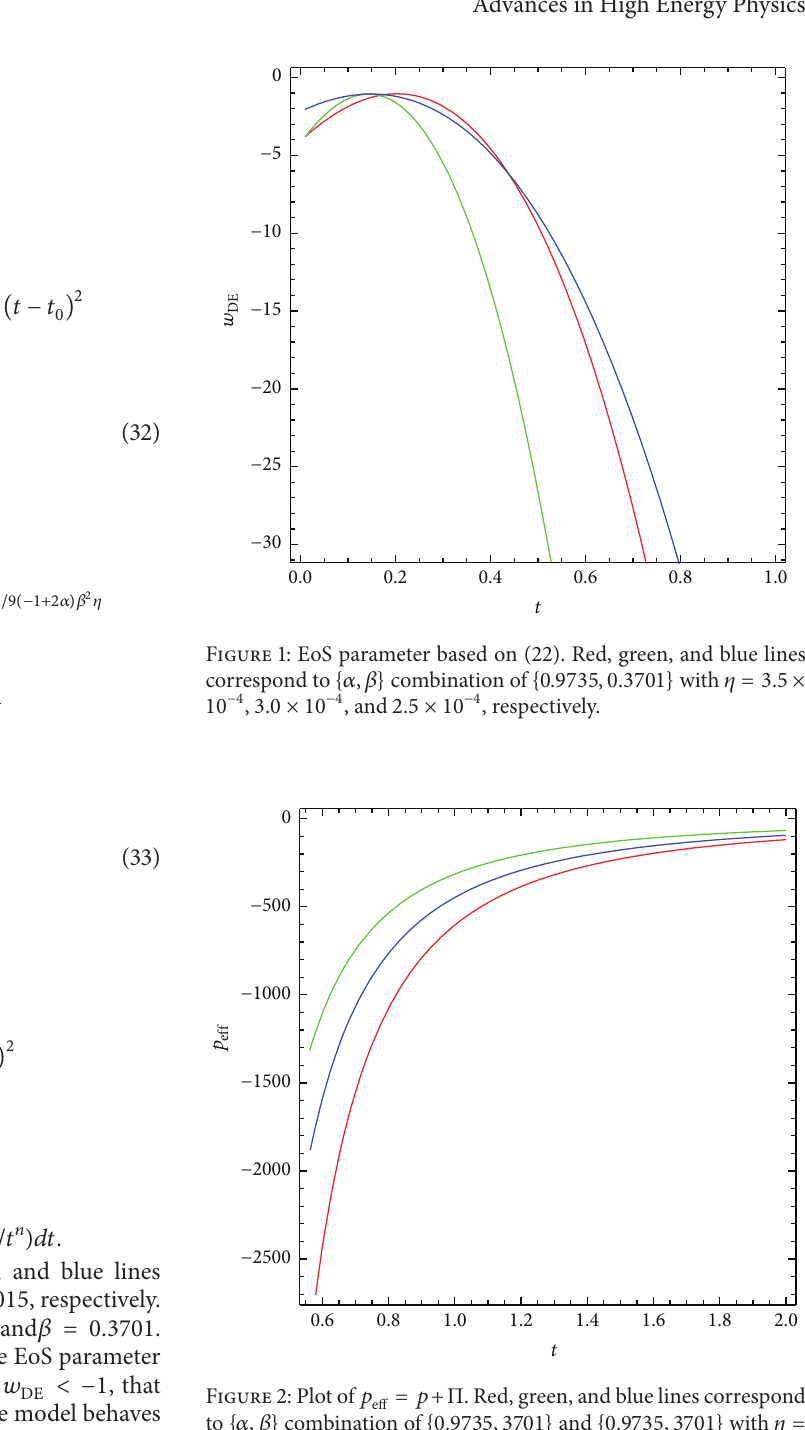
effective pressure indicates that nonequilibrium bulk viscous pressure is small compared to the local equilibrium